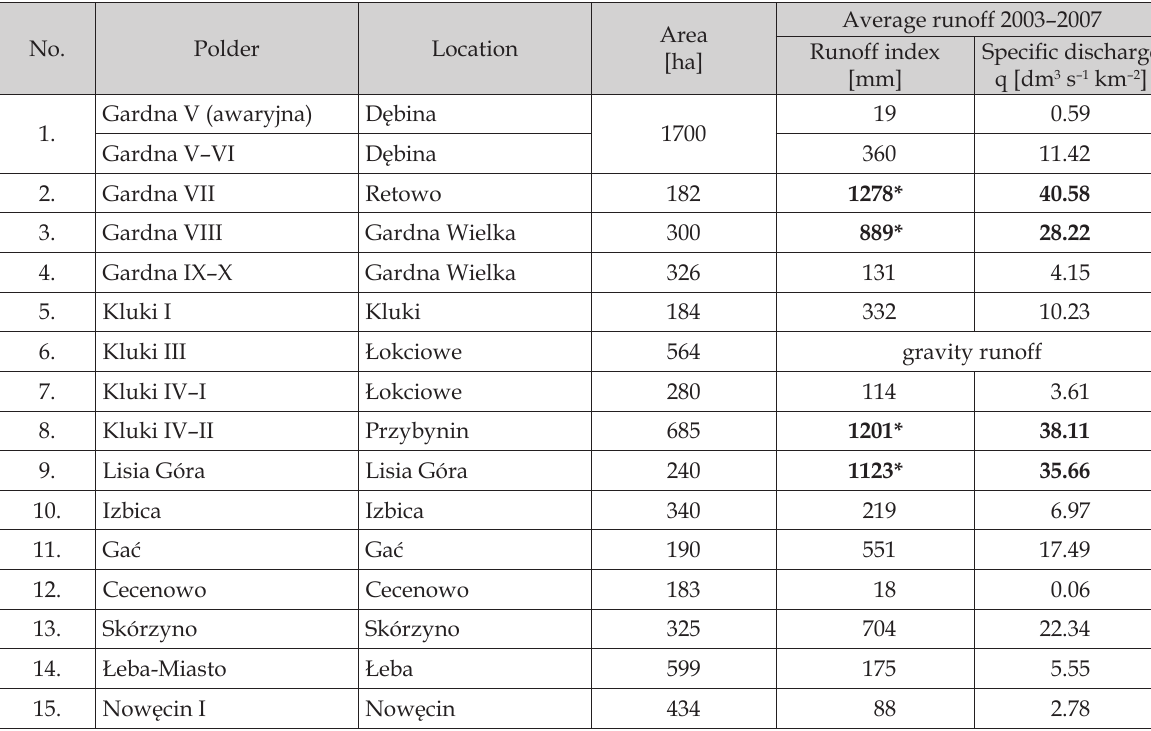
Table 1. Mean annual quantity of water discharged from polders in 2003–2007 (data from pumping stations working in the studied